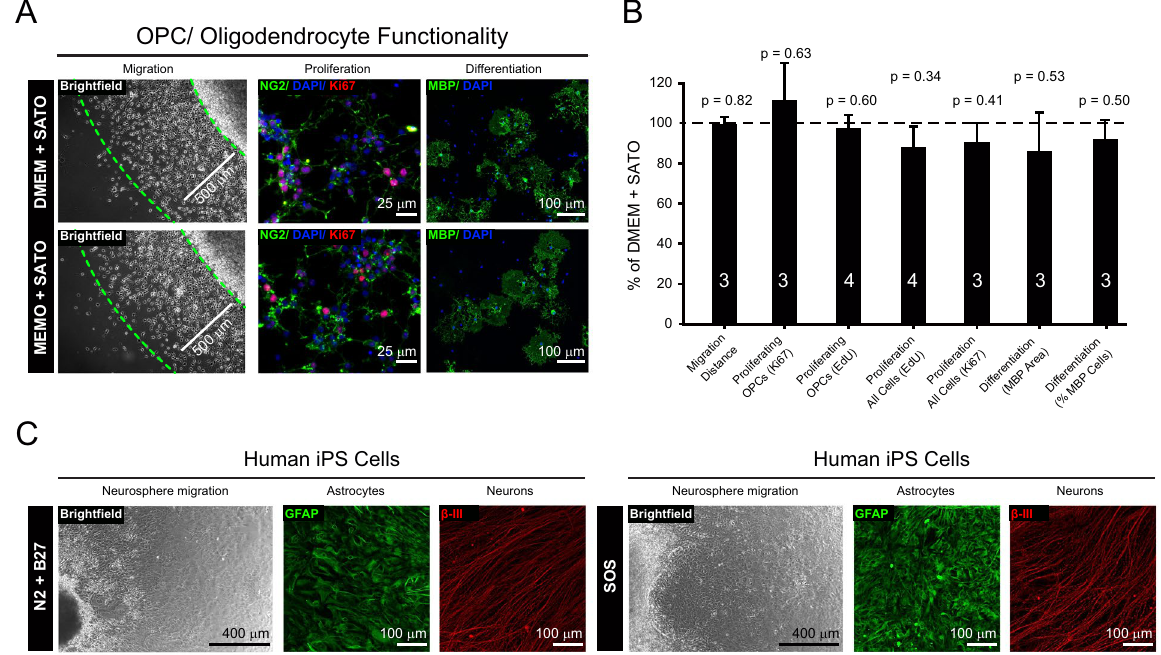
Figure 5. The new media preserves normal cell function. ( a ) Comparison of the effect of DMEM + SATO and MEMO + SATO based media upon OPC migration over 4 days from agarose drop (Brightfield images), OPC proliferation using NG2 and Ki67 staining after 3 days with mitogens PDGF-aa and FGF-b (middle panel) and OPC differentiation with terminal differentiation marker MBP after 5 days of mitogen withdrawal and treatment with T3 (right panel). ( b ) Data from ( a ) analyzed by average distances from edge of drop to corona of migrated cells, percentages of NG2 + cells with Ki67 + or EdU + and percentages of MBP + cells and percentage MBP area generated for differentiation, and all normalized to DMEM + SATO values with data representing means ± s.e.m. of a number of biological replicates (value within or above each histogram) and p -values from Student’s two tailed unequal variance t-test. ( c ) Comparison of neural epithelial cell differentiation from human iPSC generated embryonic bodies using serum free supplements N2 + B27 (left hand panels) or SOS (right hand panels) to generate neurons ( β -III) and astrocytes (GFAP) after approximately 5 weeks in vitro